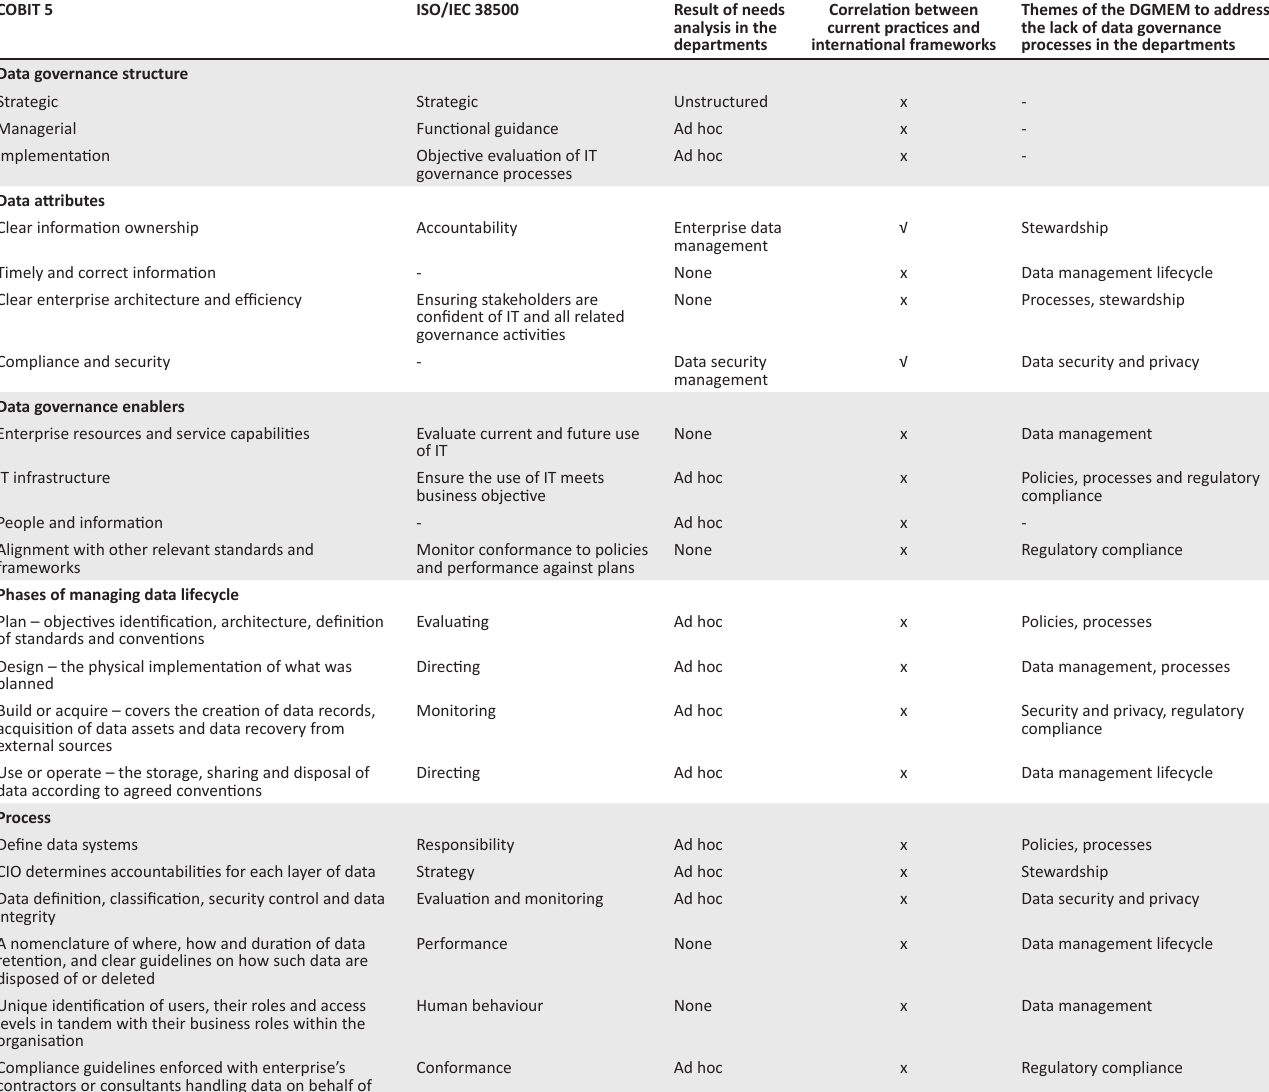
TABLE 1: Themes of the Data Governance Maturity Evaluation Model aligned with components of the COBIT 5 and International Organization for Standardization/ International Electrotechnical Commission 38500 frameworks. COBIT